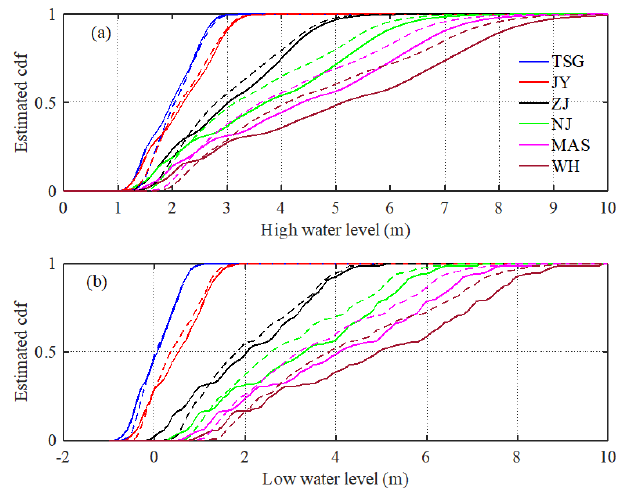
Figure 10. Cumulative distribution function (cdf) estimated by us- ing the kernel smoothing function (a) for high water level and (b) low water level at six gauging stations along the Yangtze estu- ary. The solid lines represent the pre-TGD period, while the dashed lines represent the post-TGD period.